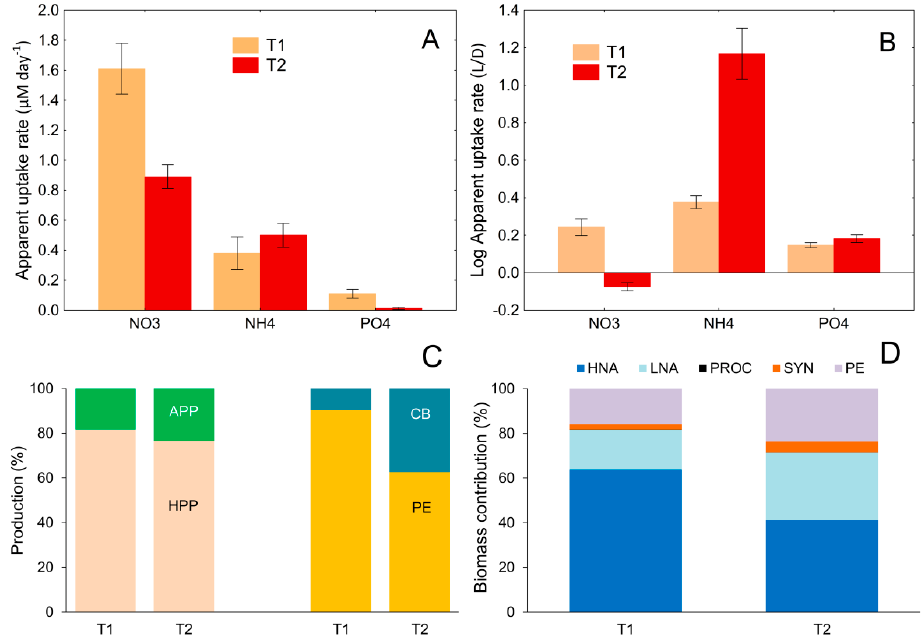
Figure 6. Apparent uptake rate (mean ± SD) of NO 3 − , NH 4 + , and PO 4 3 − ( A ), ratios of apparent uptake rates between light and dark conditions (L / D) in 2 µ m fraction ( B ), contribution of APP and HPP to total PICO production, and contribution of cyanobacteria (CB) and PE to total autotrophic picoplankton (APP) production ( C ), and biomass contribution (%) of HNA, LNA, PROC, SYN, and PE to total picoplankton biomass ( D ). All are at ambient temperature (T1) and after a 3 ◦ C rise in temperature